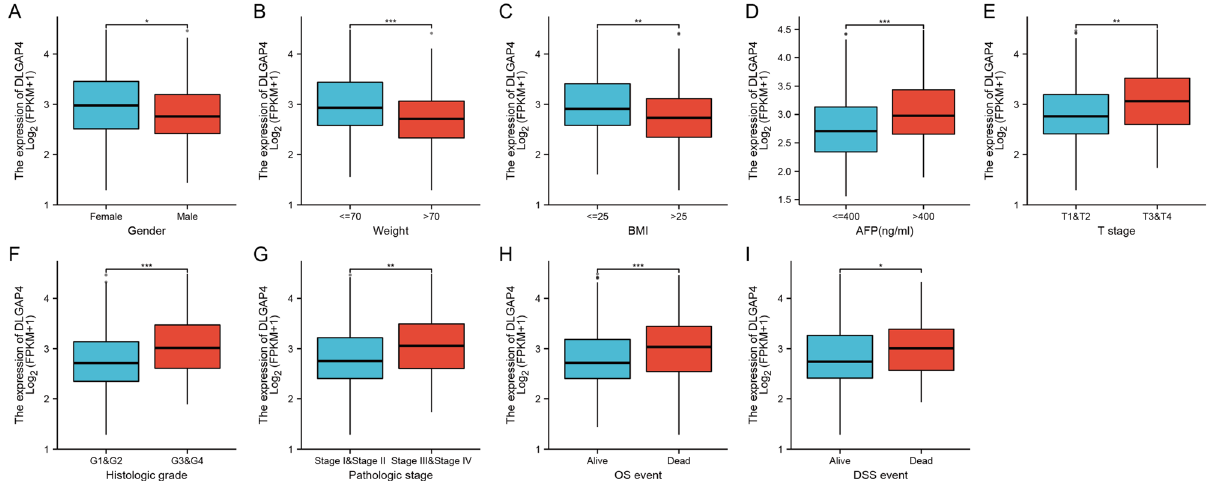
Figure 2. Box plot evaluating DLGAP4 expression in patients with HCC according to different clinical characteristics. ( A ) Gender, ( B ) weight, ( C ) BMI, ( D ) AFP, ( E ) T stage, ( F ) histologic grade, ( G ) pathologic stage, ( H ) OS event, and ( I ) DSS event. *, *** and *** represent P < 0.05, P < 0.01 and P < 0.001, respectively.